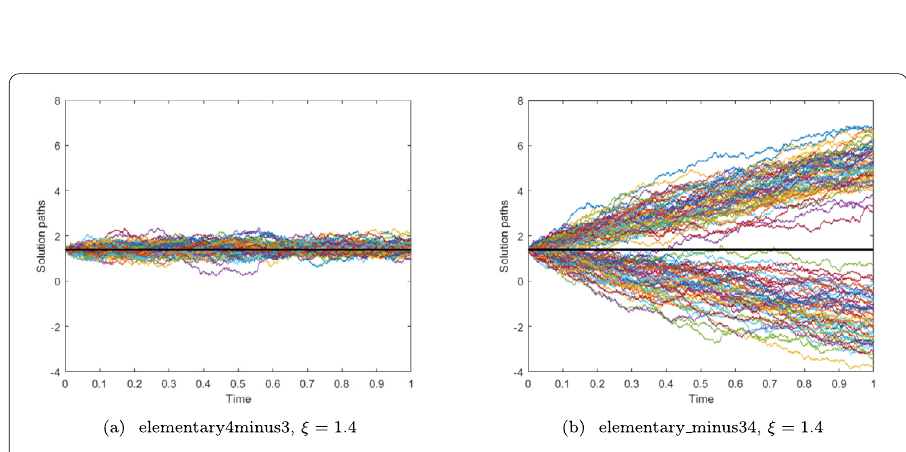
Figure 2 Comparison of solution paths: elementary4minus3 vs. elementary_minus34